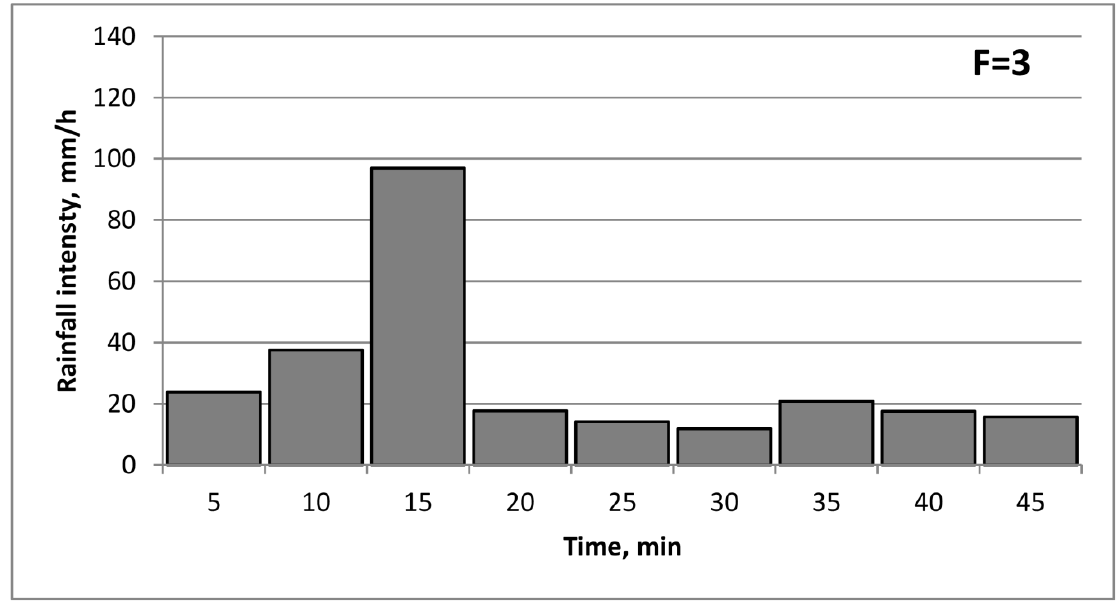
Figure 7. Rainfall scheme of Euler type II model—duration 45 min. (frequency of occurrence of modelled rainfall F = 3) [40,41].